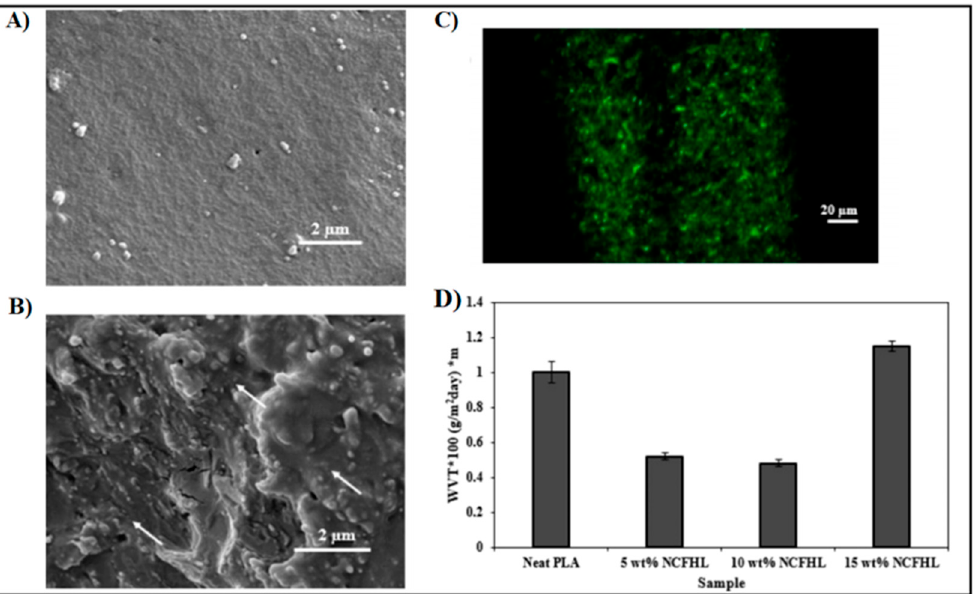
Figure 14. TEM image of ( A ) neat PLA and ( B ) the PLA–NCFHL biocomposite (with lignin) in which fibrils were well embedded within the PLA matrix (indicated by arrows); ( C ) confocal laser microscope image showing well dispersed lignin fibrils on the PLA surface; ( D ) Water vapor transmission rate of the neat PLA and PLA/lignin biocomposite. Adapted from [248] with permission from American Chemical Society. Copyright © 2018.